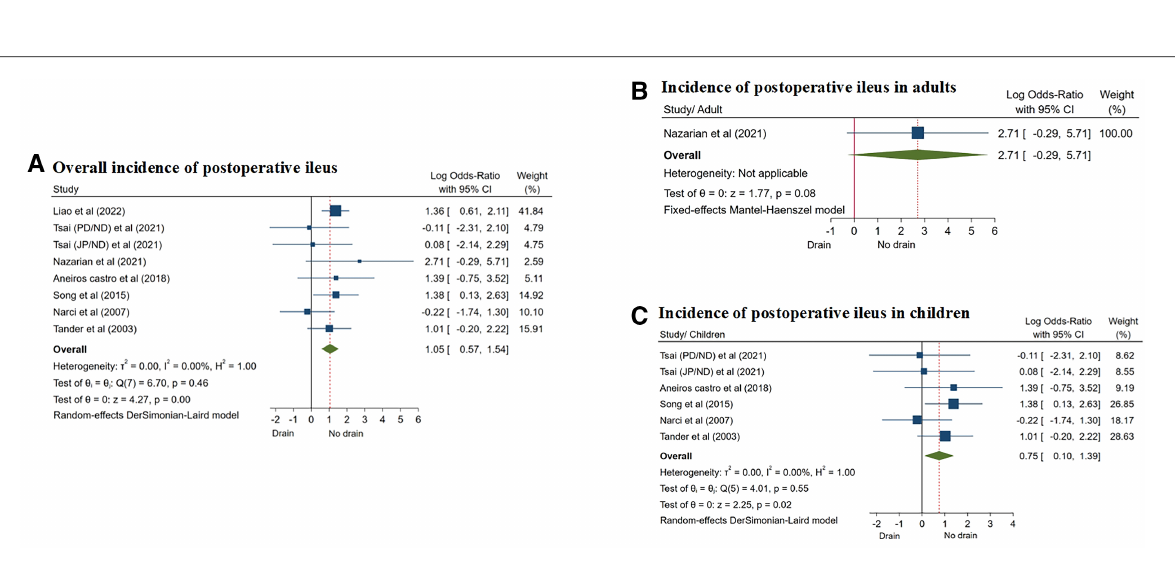
FIGURE 7 Forest plots of meta-analysis and subgroup meta-analysis comparing postoperative ileus, ( A ) overall incidence of postoperative ileus; ( B ) incidence of postoperative ileus in adults; ( C ) incidence of postoperative ileus in